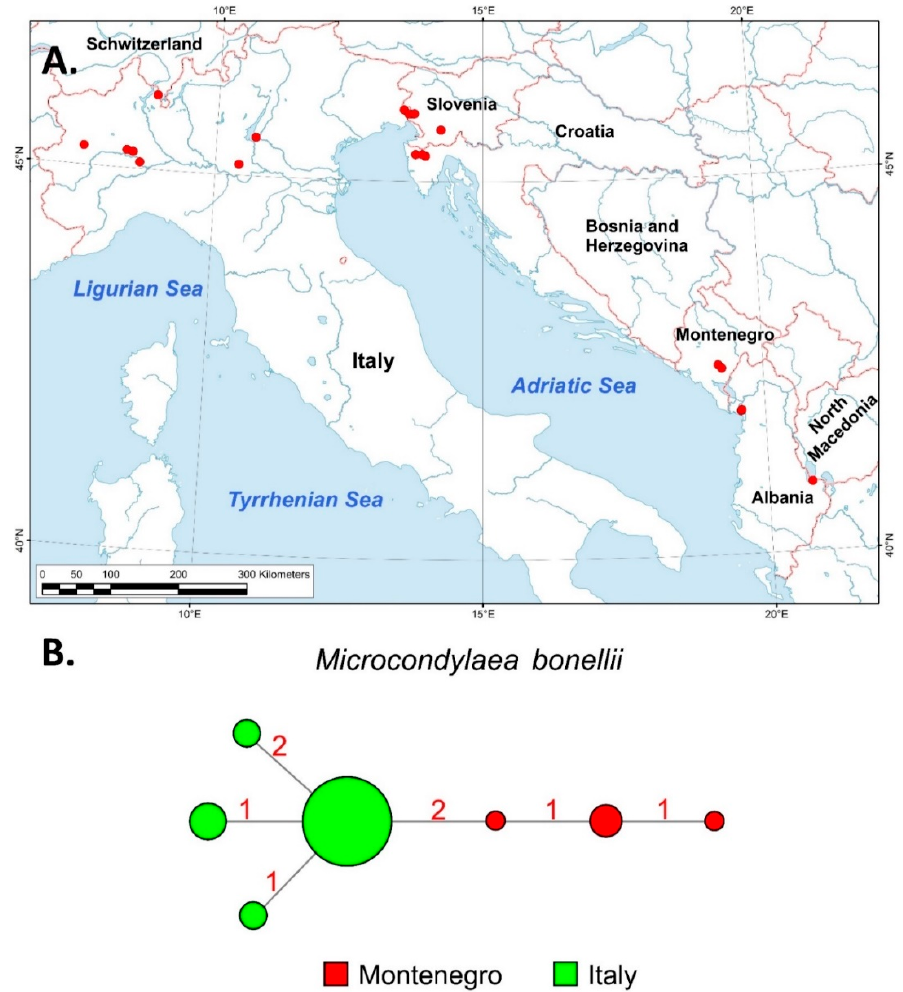
Figure 3. Distribution and phylogeography of Microcondylaea bonellii : range map ( A ) and median- joining network ( B ).